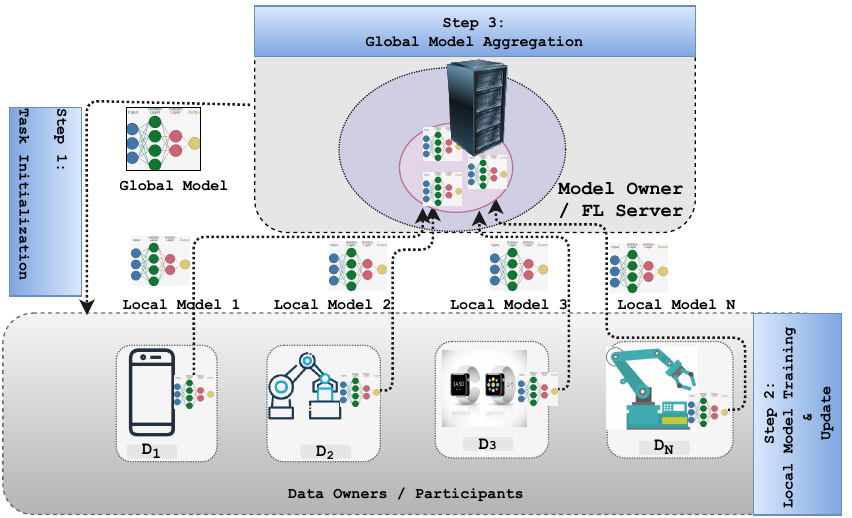
Figure 3. An FL general process with the server and N participants synchronizing with a server and updating it with an updated global model in a single communication